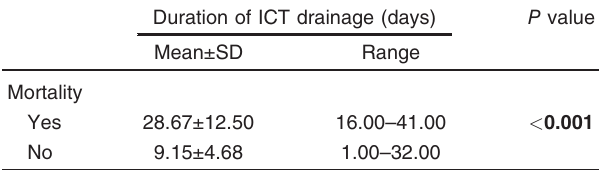
Table 4 Relation between mortality and duration of ICT drainage Duration of ICT drainage (days)